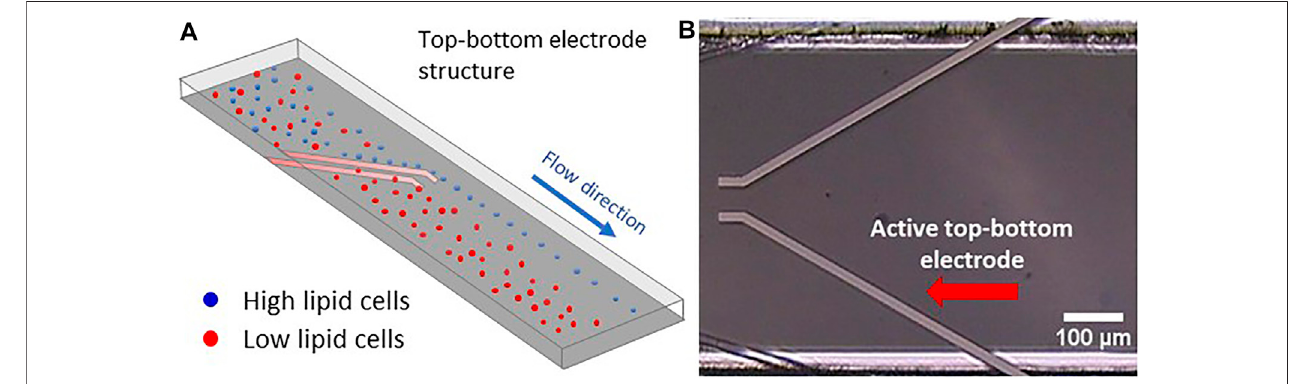
FIGURE 5 | Top-bottom electrode structure with electrically conducting metal layers integrated into the top and bottom walls of the micro fl uidic channel. (A) Simulation of microalgae fl ow between a top-bottom electrode structure in a micro fl uidic fl ow cell. Here, the high lipid cells (blue colour) are being repelled at the electrodesedge ending uptothe right outlet region while the lowlipid cells are fl oating through thetop-bottom electrode ending to theleft outlet region. (B) Microscopic viewofthemicro fl uidicchannelwithtwotop-bottom electrode pairs.Theactive pairisindicatedbyaredarrow (inthisviewonlythetop electrodes arevisible,while the bottom ones are hidden right